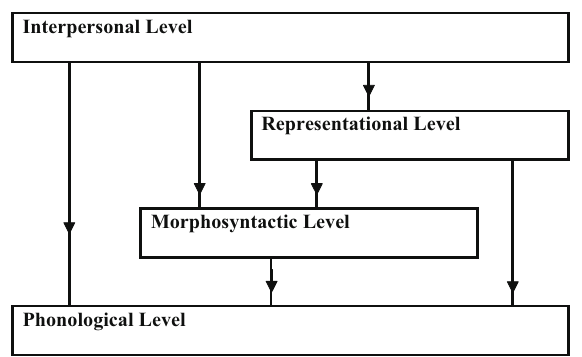
Figure 1: The top - down organization of FDG.